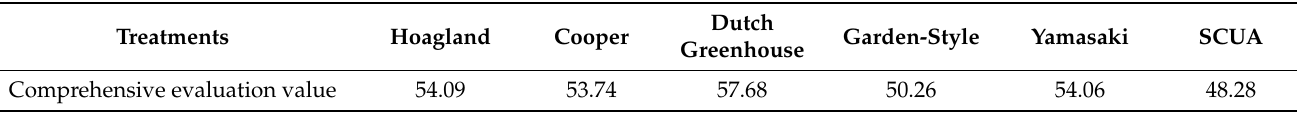
Table 5. Comprehensive evaluation value of different nutrient solution formula cultivation of water